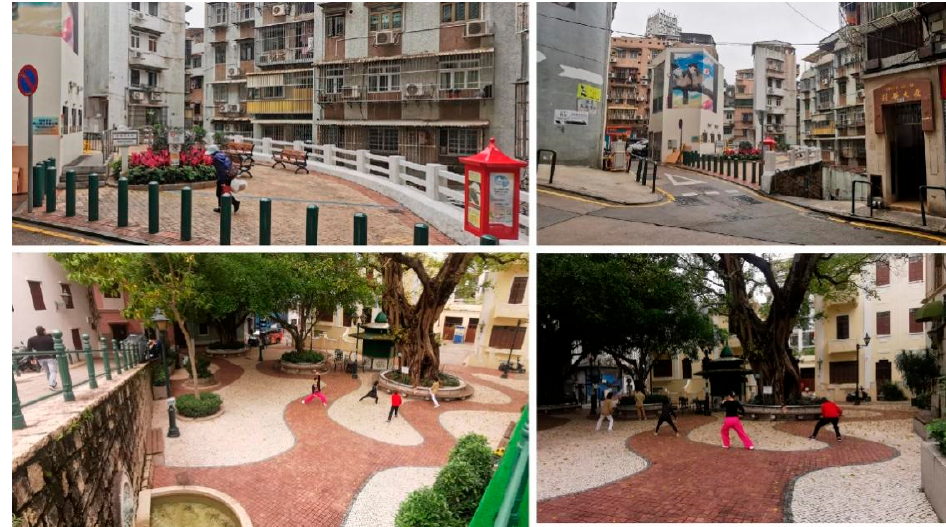
Figure 10. Community-related Largos.